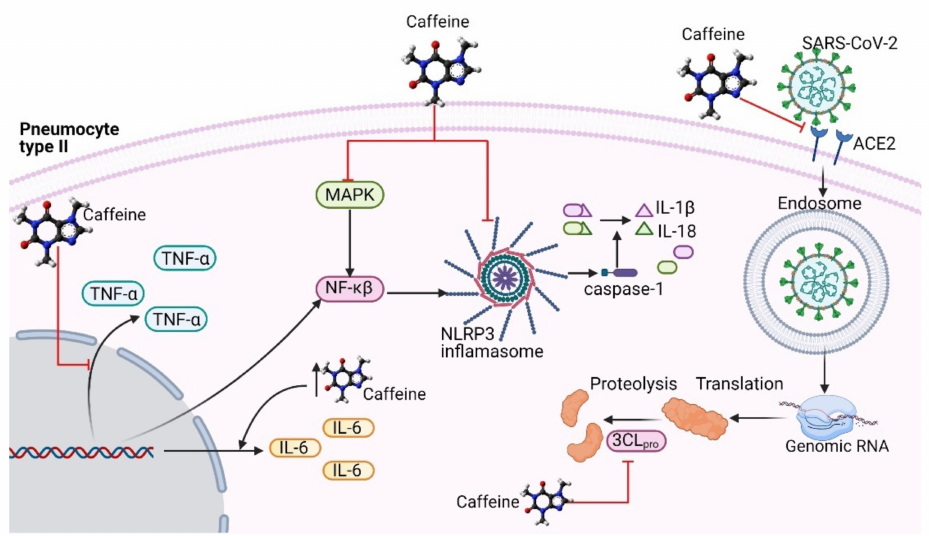
Figure 2. Schematic diagram of the proposed antiviral mechanisms of caffeine against SARS-CoV-2. Caffeine can inhibit the production of TNF- α and the expression of the inflammasome NLRP3 and its activity by the MAPK/NF- κβ pathway, decreasing the production of IL-1 β and IL-18. Caffeine also inhibits viral entrance by blocking the RBD and ACE2 complex formation. Caffeine also inhibits 3CL pro , a protease required to release two polypeptides that are necessary for viral transcription and replication. TNF- α , tumor necrosis factor alpha; NF- κβ , nuclear factor kappa beta; ACE2, angiotensin-converting enzyme 2; NLRP3, inflammasome NOD-like receptor 3; IL-6, interleukin 6; IL-1 β , interleukin 1 beta; IL-18, interleukin 18; MAPK, mitogen-activated protein kinase; 3CL pro , 3-chymotrypsin-like